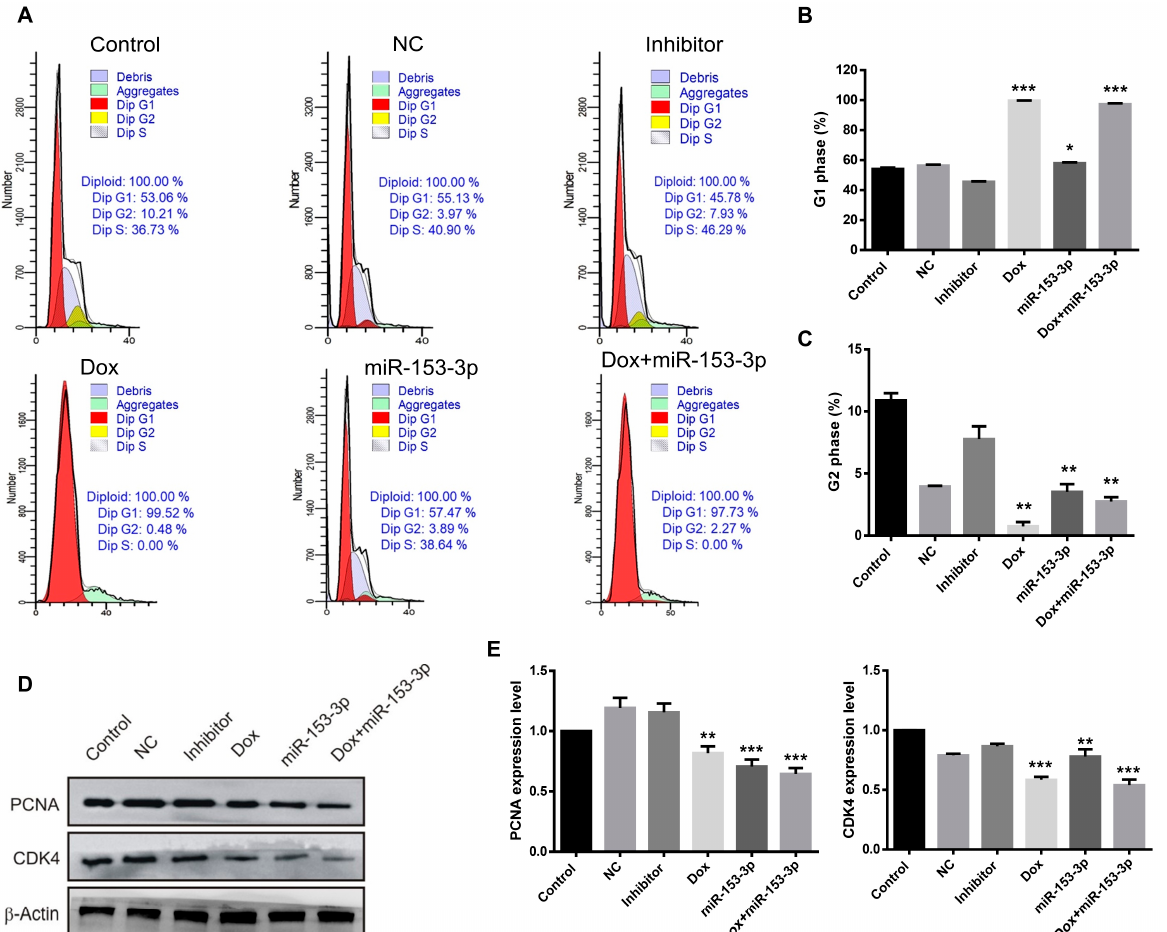
Figure 8. Effects of miR-153-3p, Dox, and miR-153-3p+Dox treatment on the cell cycle in MCF-7 cells. ( A ) Cell cycle phase distribution by flow cytometry. ( B , C ) Quantification of the G1 and G2 phases. ( D , E ) Western blotting of CDK4 and Cyclin D1 and their quantification (* p < 0.05; ** p < 0.01; *** p < 0.001, original blot see Supplementary File S1).